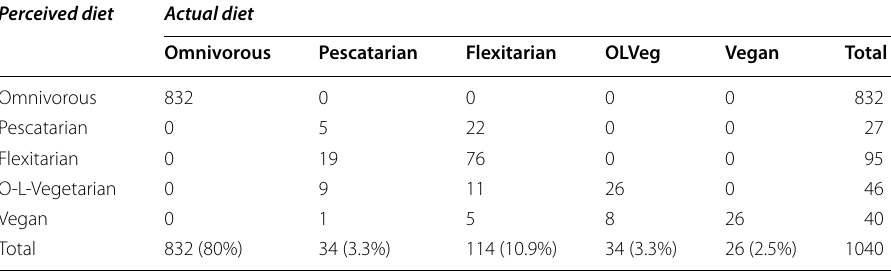
Table 4 Comparison between perceived diet and actual diet Perceived diet Actual diet Omnivorous Pescatarian Flexitarian OLVeg Vegan Total Omnivorous 832 Pescatarian Flexitarian